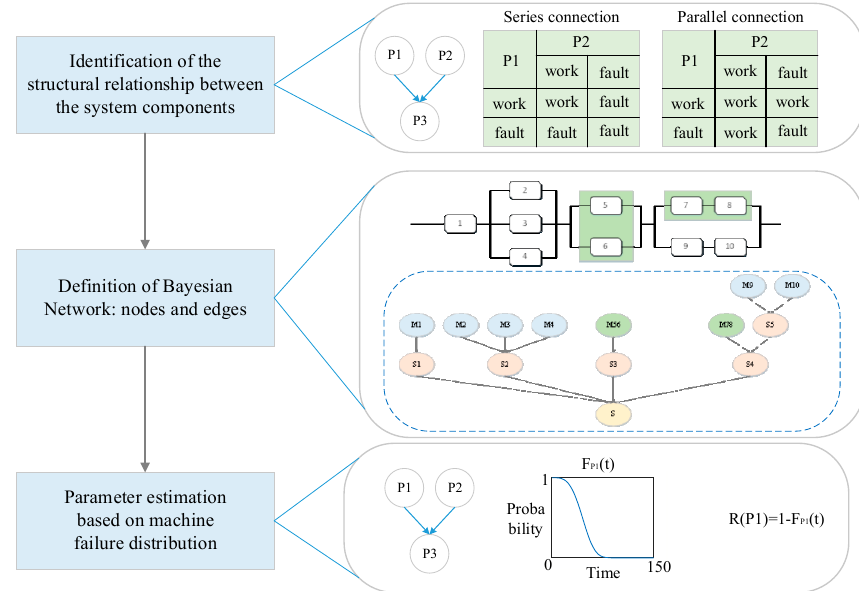
Figure 4. Bayesian network construction.